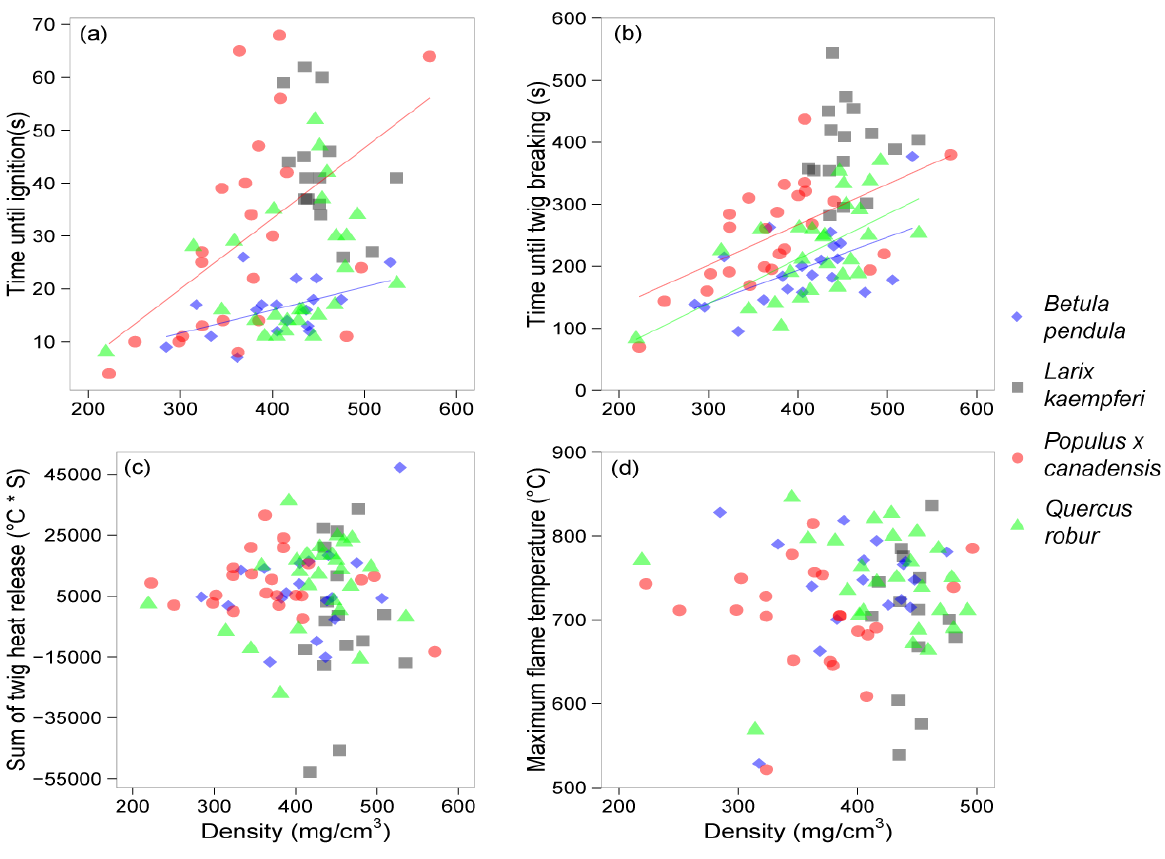
Figure 4. Density versus flammability variables of air-dried twigs of all four species: ( a ) time until ignition, ( b ) time until twig breaking, ( c ) sum of twig heat release and ( d ) maximum flame temperature; Only significant relationships within species are shown with regression lines (Table